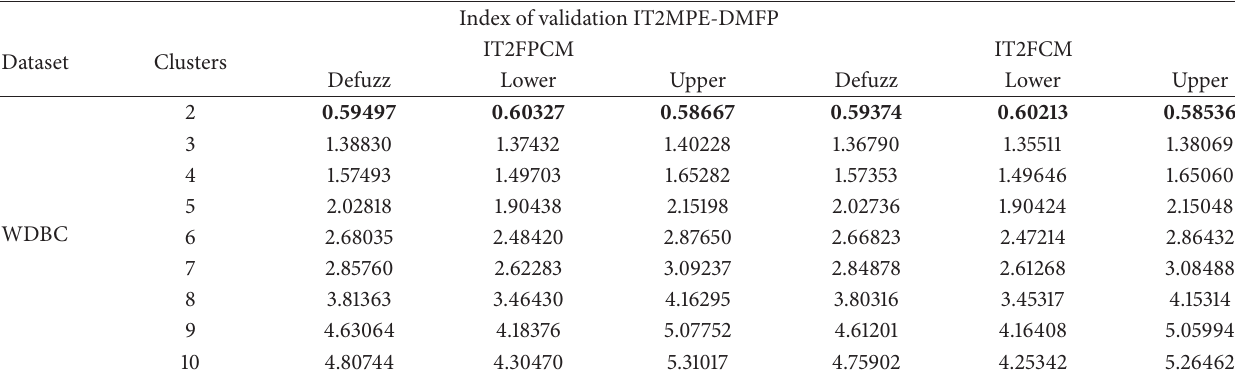
Table 1: Results of the IT2MPE-DMFP validation index for the WDBC dataset clustering using IT2FPCM and IT2FCM algorithm using 𝑚 = [1.5, 2] and 𝜂 = [1.5, 2.5] as the parameters.